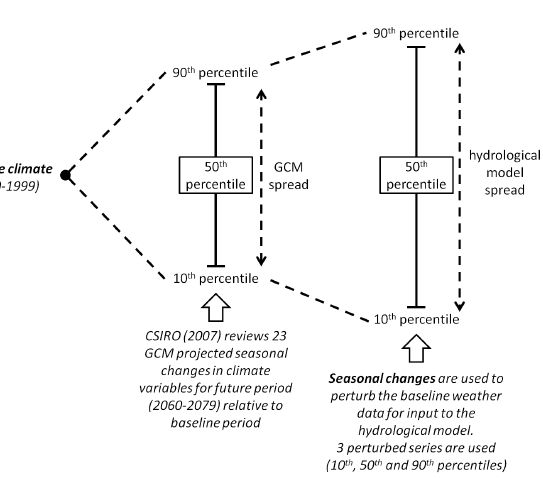
Fig. 5. Schematic showing climate scenario development and treat- ment of model spread.